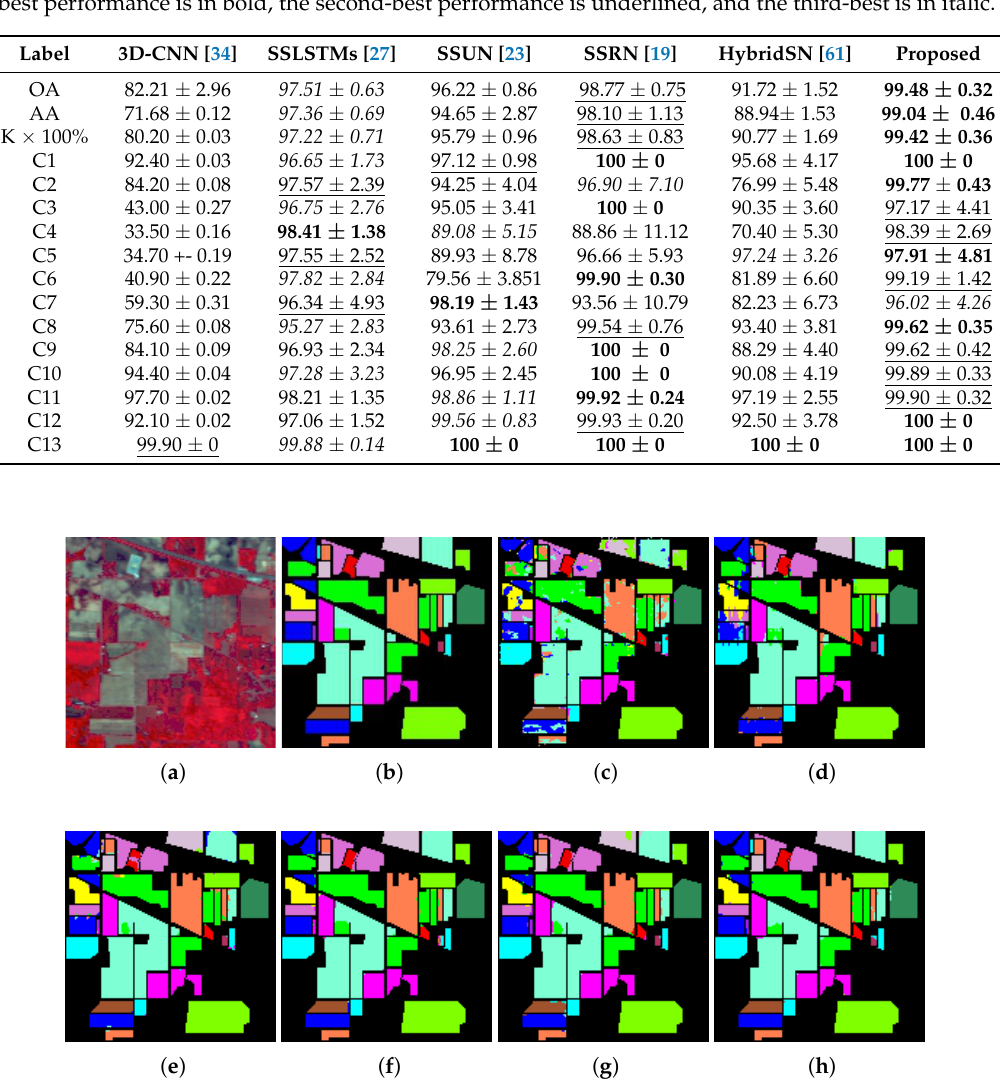
Table 8. Overall Accuracy, Average Accuracy, Kappa Value, and Class Wise Accuracy of our proposed method versus other methods on Kennedy Space Center (KSC) dataset with 10% training samples. The best performance is in bold, the second-best performance is underlined, and the third-best is in italic.